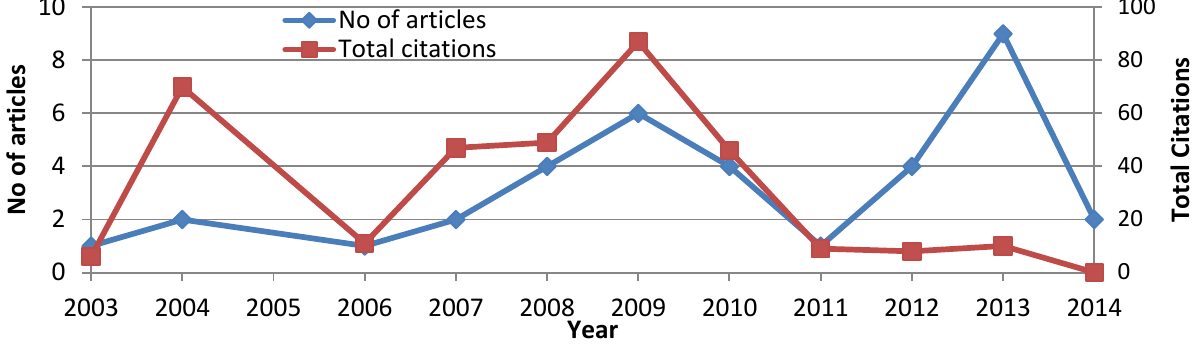
Figure 2. Total article citations and number of citations over the years.